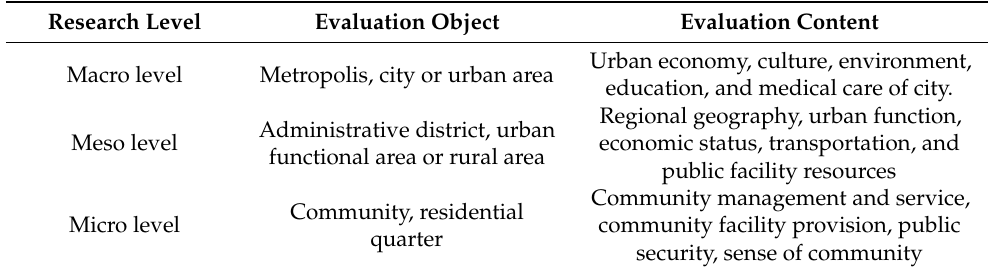
Table 1. Evaluation livability of three